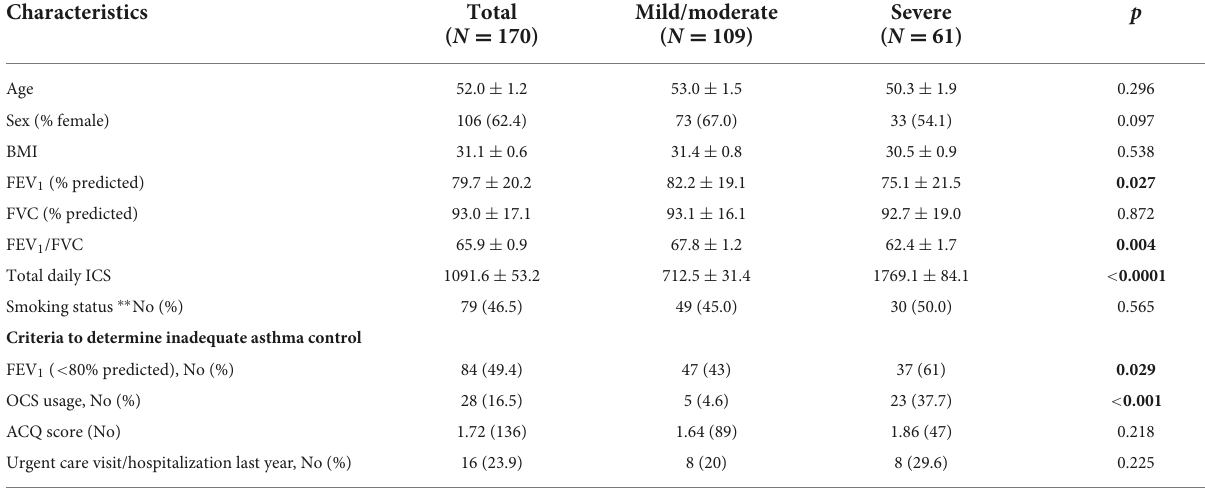
TABLE 1 Clinical characteristics of study subjects.